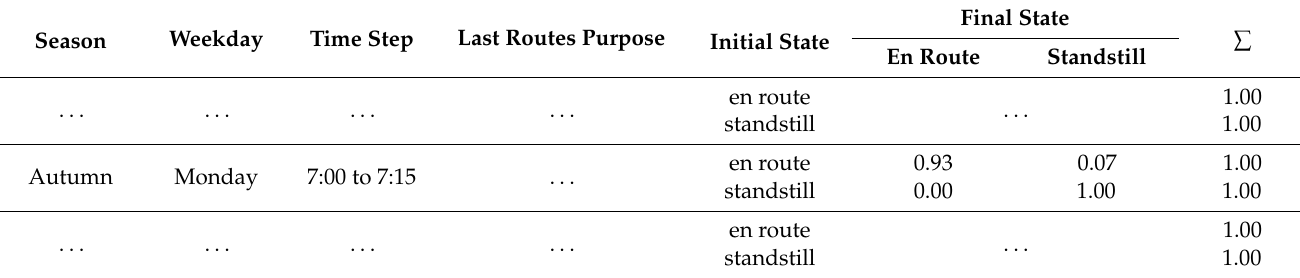
Table 1. Structure of the transition matrix for the condition of the car with exemplary entries. Season